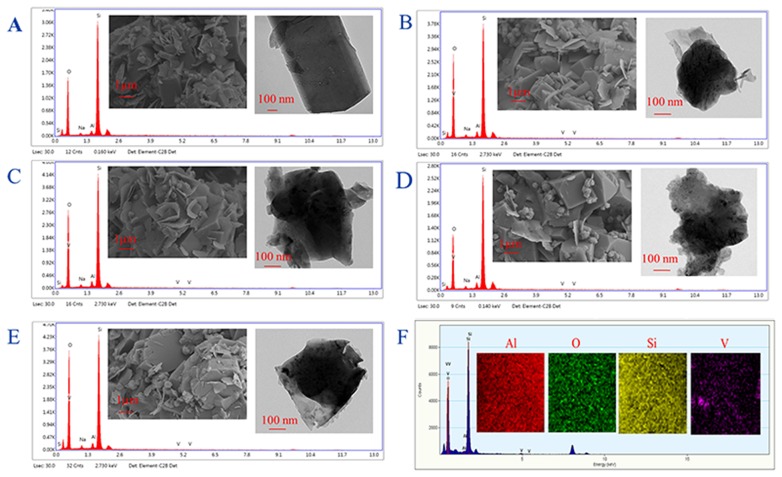
SEM and TEM images (insert) and EDX spectra of ZSM-5 zeolites: PZSM (A), V1/ZSM450
(B), V1/ZSM550
(C), V2/ZSM450
(D), and V2/ZSM550
(E) and element mapping-EDS spectra of V1/ZSM450
(F).